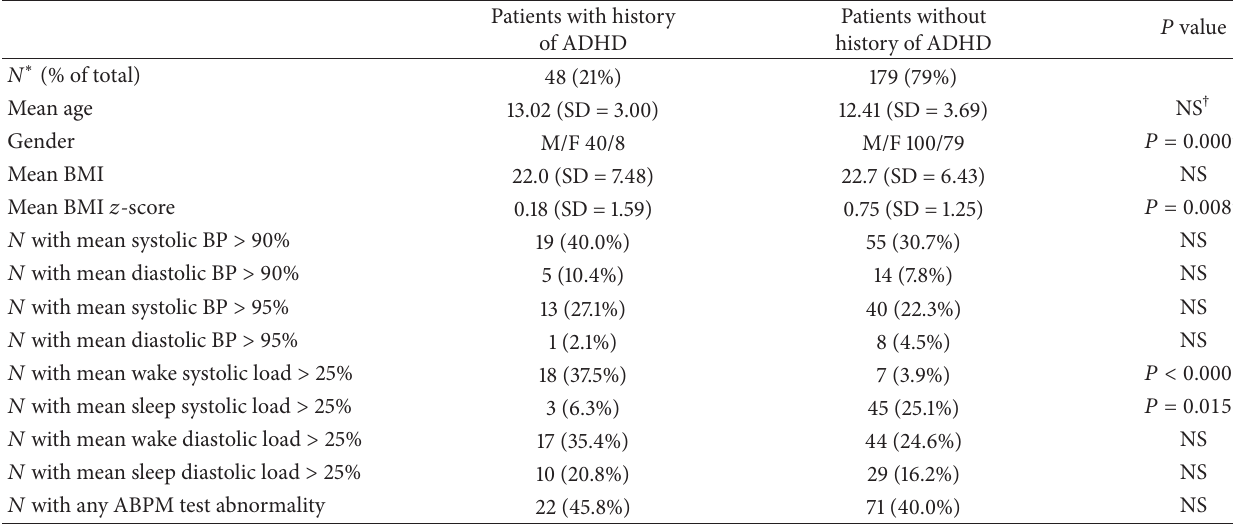
Table 1: Patient characteristics and ABPM results. Patients with